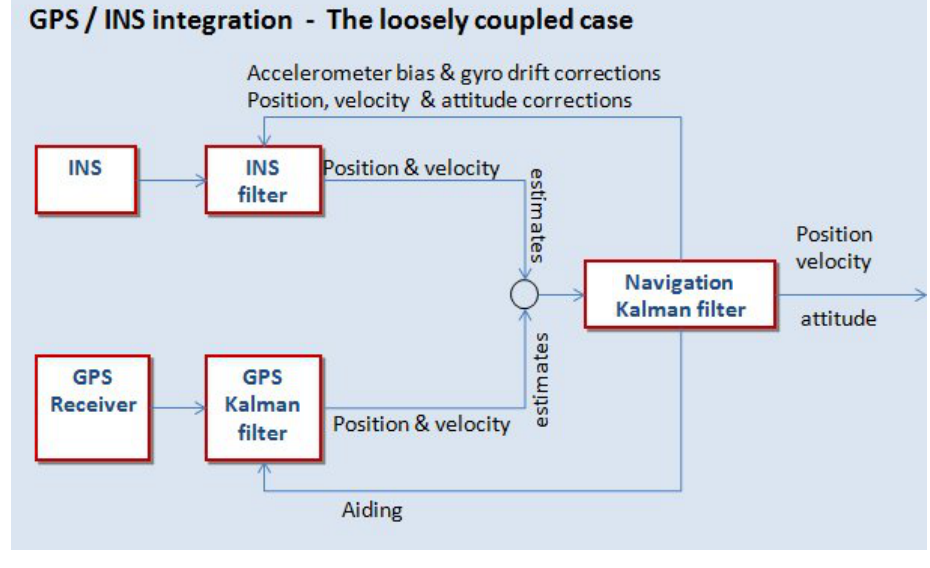
Figure 3. GPS/INS integration using Kalman filter. The loosely coupled